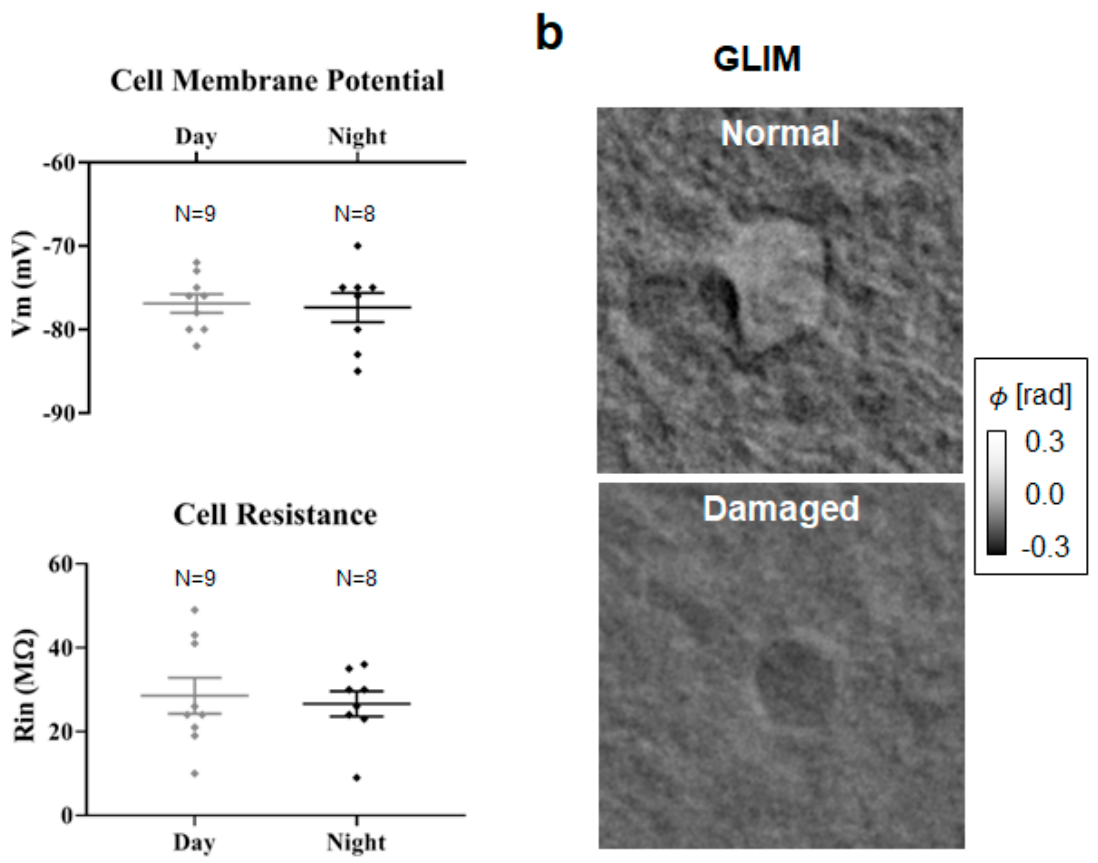
Figure 4. Astrocytes during the circadian cycle are indistinguishable by electrophysiology. ( a ) Comparison of day vs. night cells shows no statistically significant difference in membrane potential and resistance values. ( b ) GLIM reports different phase maps for normal and damaged cells (63 × /1.0NA